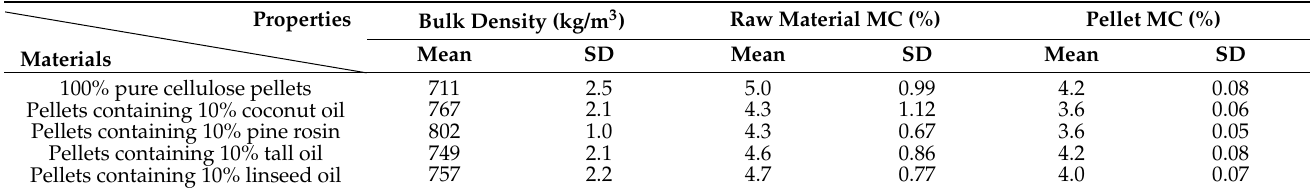
Table 1. Moisture content (MC) and bulk density for the five different types of pure cellulose pellet.